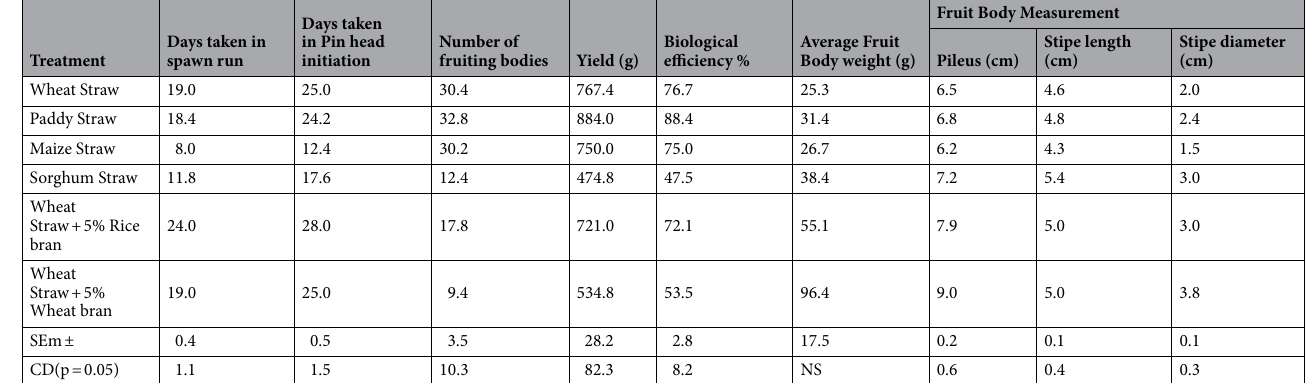
Table 1. Effect of different substrates on spawn run, pinhead initiation, yield and morphology of Pleurotus eryngii. SEm ± : Standard error of the mean. CD(p = 0.05) : Critical difference, where p = level of significance. All the observations are average of five replications.